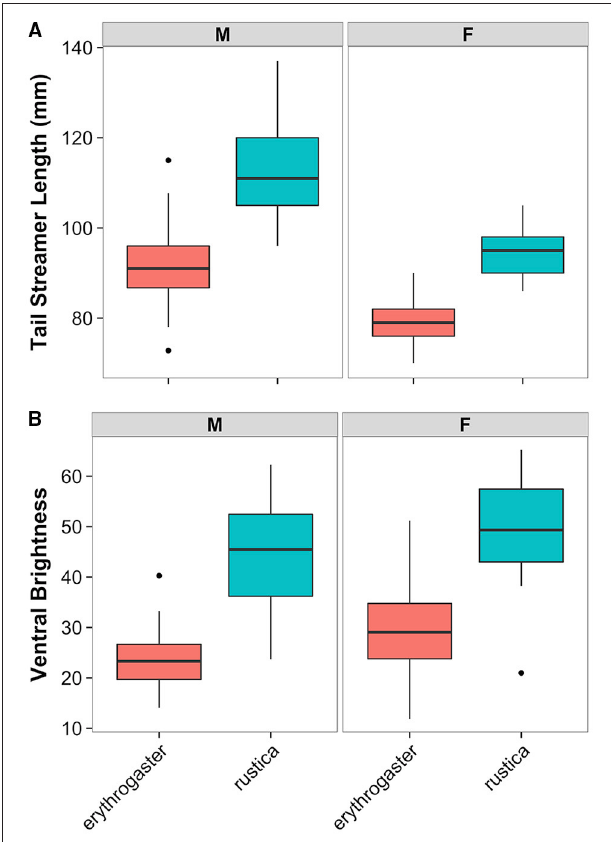
FIGURE 1 | The elaboration of sexual traits in divergent populations of barn swallows. (A) North American H. r. erythrogaster (red) have significantly shorter tail streamers than European H. r. rustica (blue) in both males and females. (B) H. r. erythrogaster of both sexes also have darker ventral